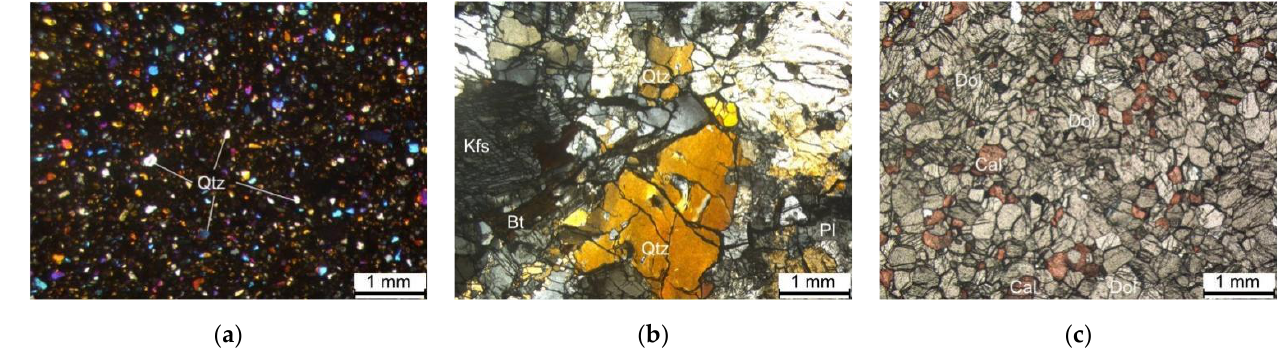
Figure 9. Microstructure of ( a ) red sandstone, ( b ) granite, and ( c ) marble obtained from the transparent refractive index experiments. The particle size and distribution of red sandstone and marble are relatively uniform but vary greatly in granite.